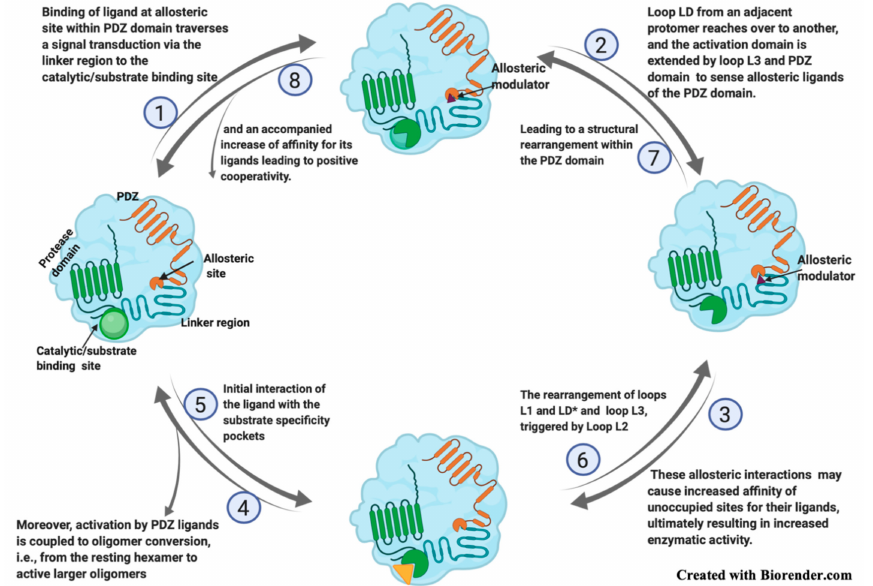
Figure 2. The interplay between the catalytic and allosteric sites in DegP. The structural rearrange- ment of substrate-binding pockets, proper positioning of the catalytic triads, and formation of the oxyanion holes occur via allosteric signal transduction across protomers resulting in structurally connected active sites and, ultimately in a positively cooperative